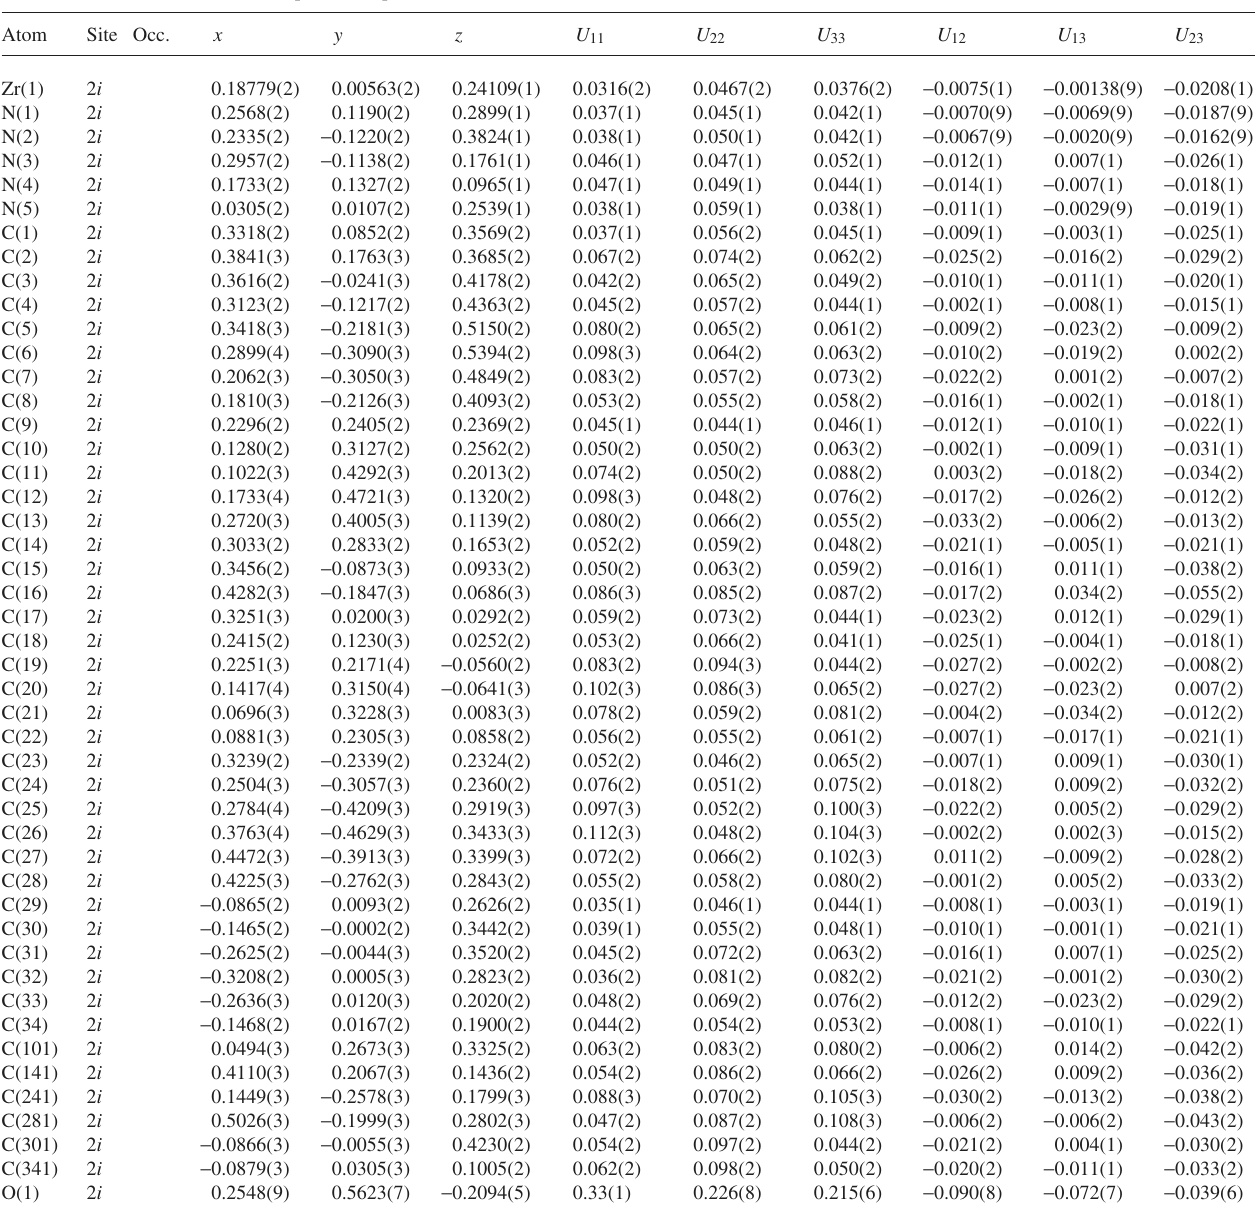
Table 3. Atomic coordinates and displacement parameters (in Å 2 )